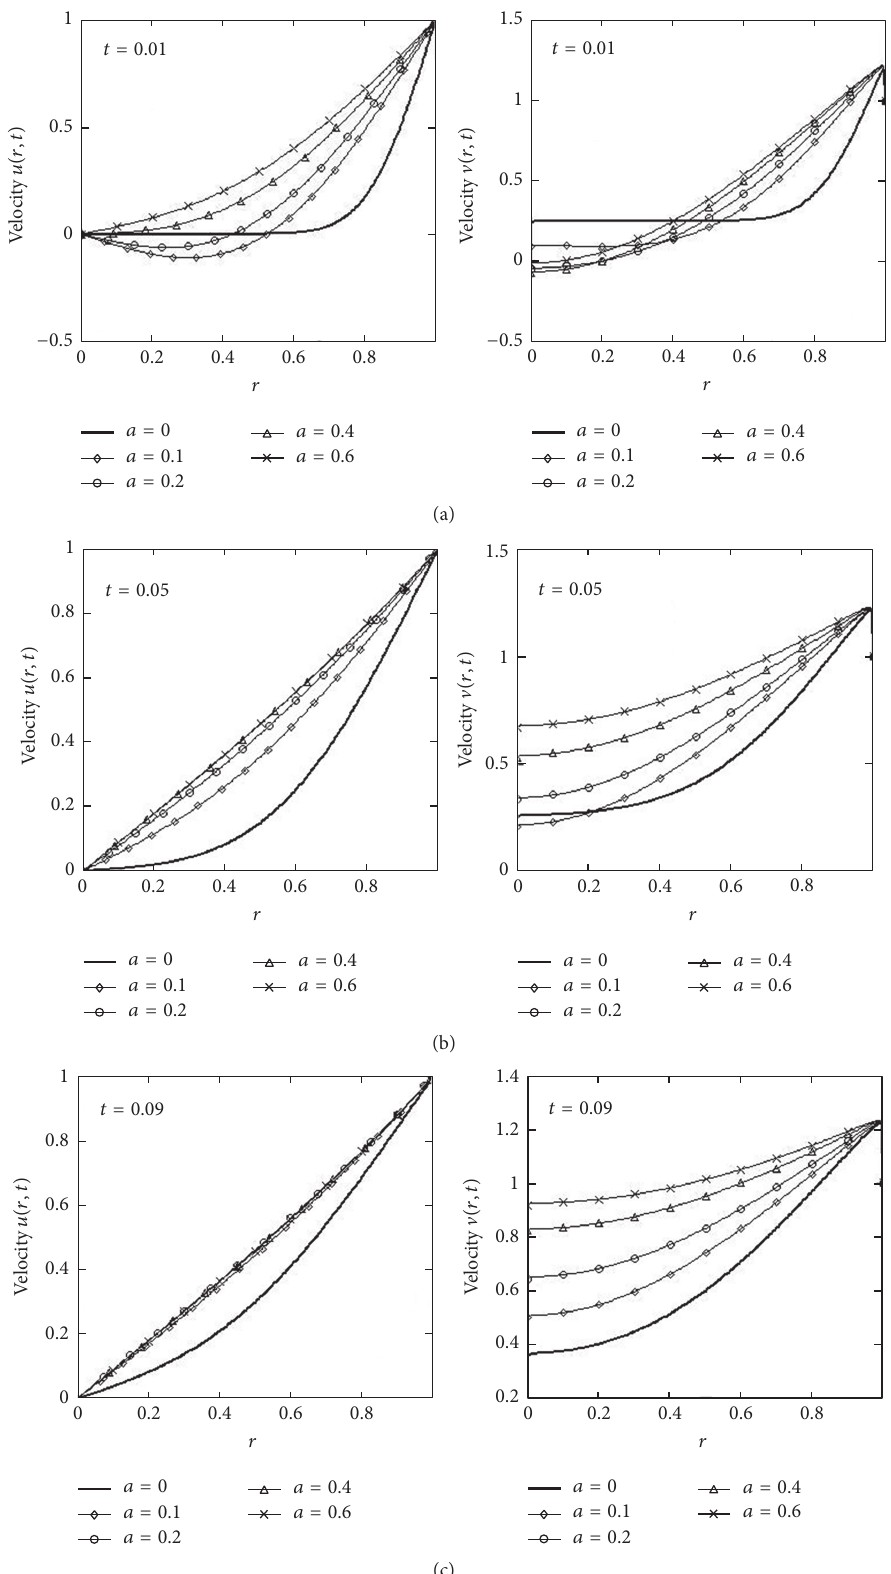
Figure 1: Profiles of azimuthal velocity 𝑢(𝑟, 𝑡) and axial velocity V (𝑟, 𝑡) for small time and different values of scale parameter 𝑎